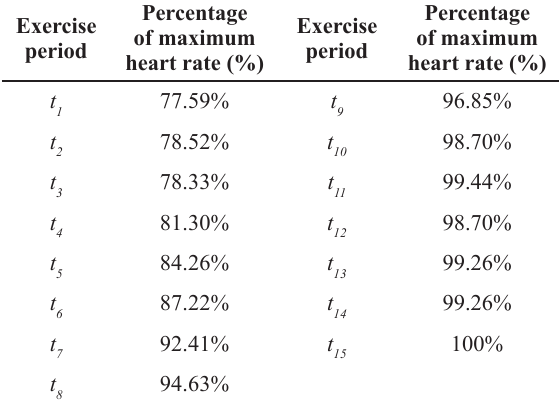
Percentage of maximum heart rate in rats by